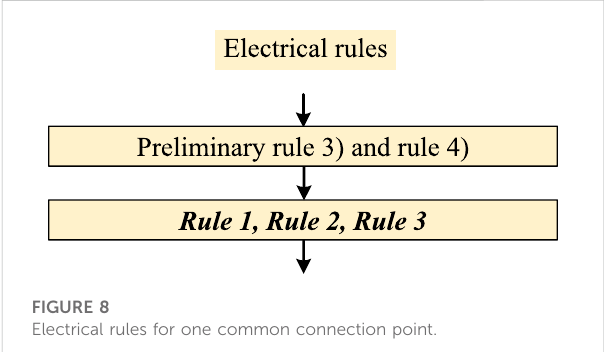
FIGURE 8 Electrical rules for one common connection